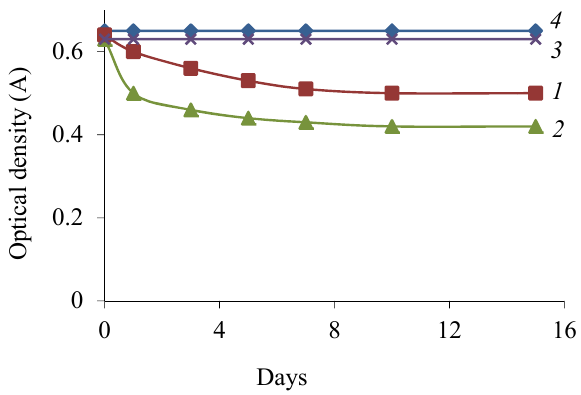
Fig. 11. Change in the color intensity of raspberry nectar prepared on the basis of aqueous solutions without organic impurities ( 4 ) and those that contain trichlorethylene ( 1 ), dichloroethane ( 2 ) and chloroform ( 3 ) over time.